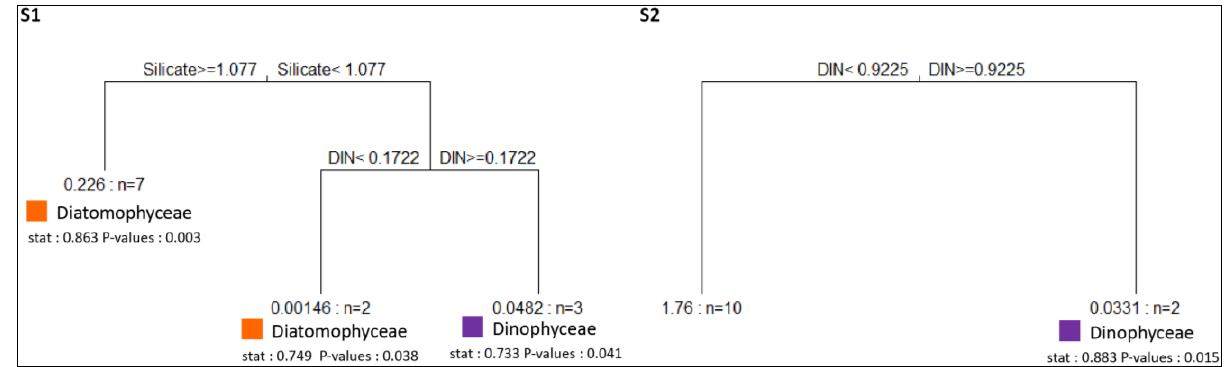
Figure 10. Multivariate Regression Tree (MRT) and corresponding indicator classes of phytoplankton for S1 and S2. Composition of phytoplankton assemblages are the response